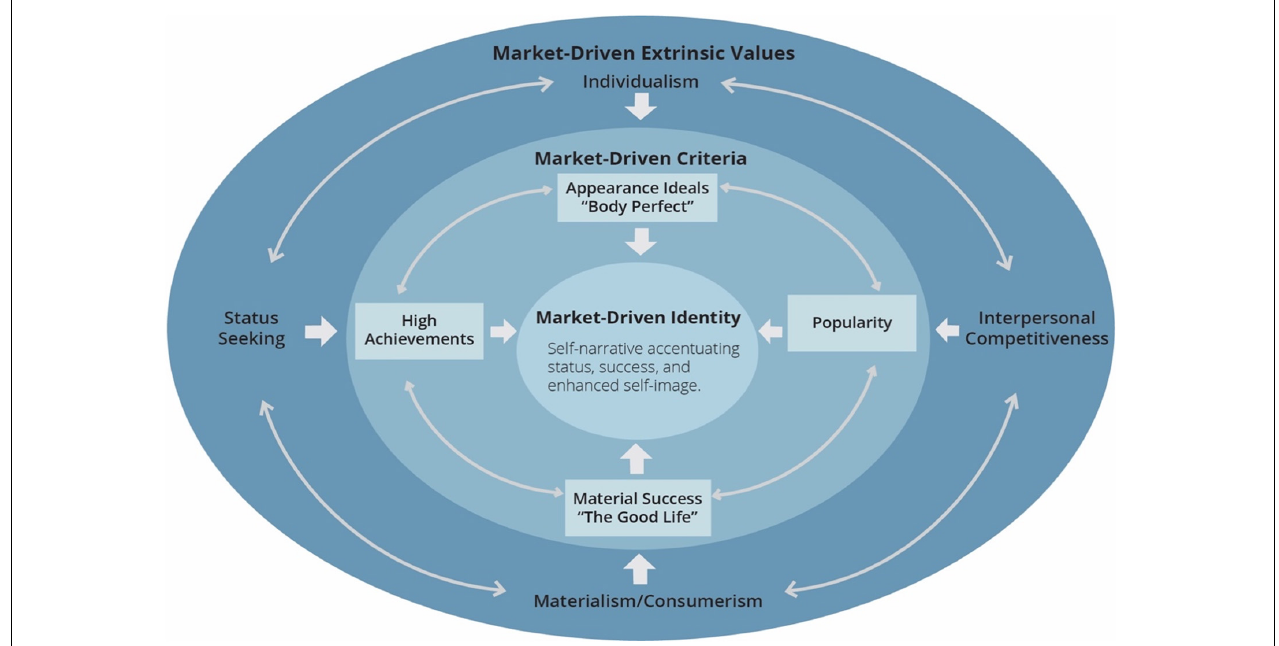
FIGURE 1 | The macro-cultural context of market-driven identities in young people. Moving clockwise, the outer circle illustrates key market-driven extrinsic values, which are embodied by specific market-driven criteria, shown in the inner circle. These market-driven criteria, in turn, inform young people’s identity narratives, the circle at the